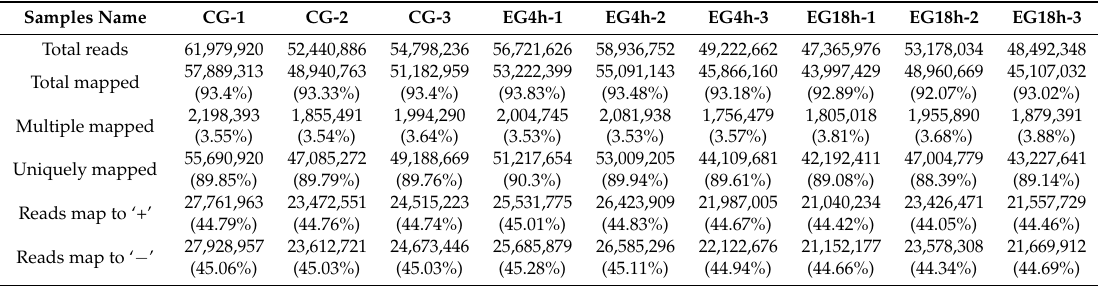
Table 1. Mapping analysis of clean data with reference genomes of grass carp (three technical replicates (individual wells) were pooled into one biological replicate, each sample represent one biological replicate).